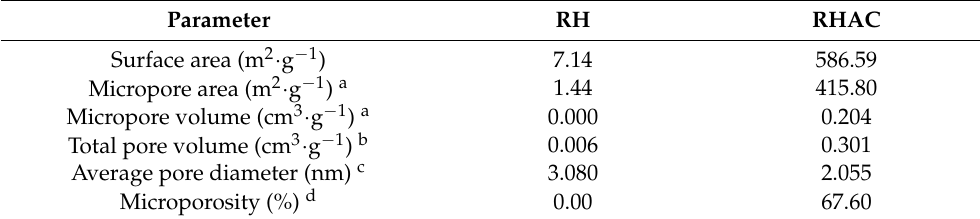
Table 1. Characteristics of rice husk (RH) pore’s texture and rice husk activated carbon (RHAC).